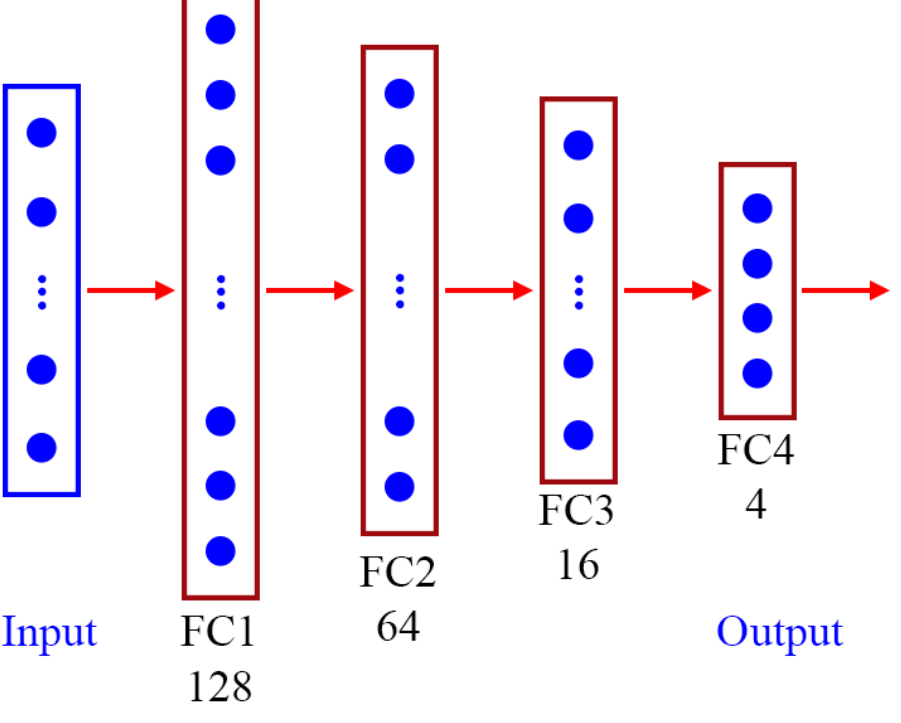
Figure 7. Architecture of the DNN